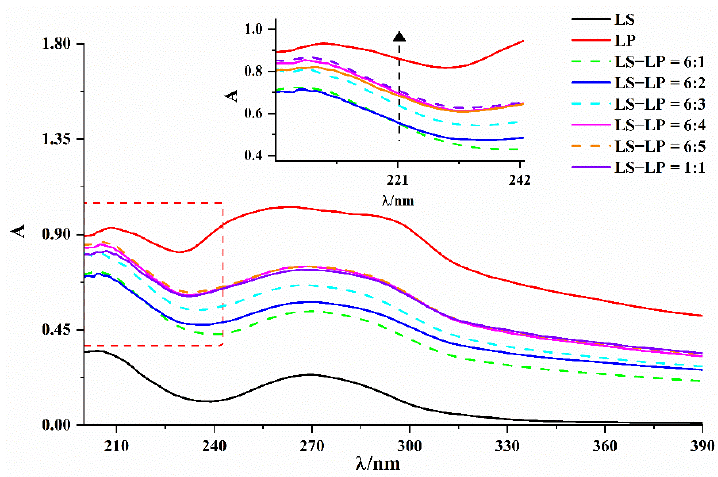
Figure 2. UV–vis absorption spectra of lotus seed starch–protein mixture. Note: The figure displayed that lotus seed starch–protein mixture (LS-LP). LS indicates lotus seed starch. LP indicates lotus seed protein. LS-LP = 6:1–5 or 1:1 indicates lotus seed starch–protein with different ratio.